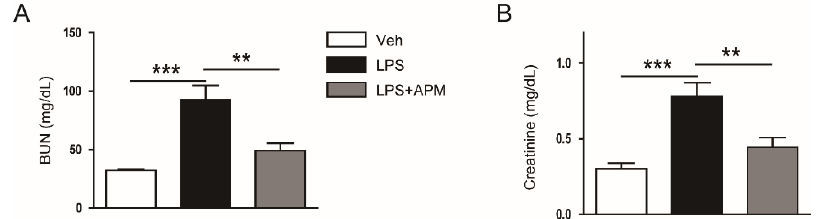
Figure 1. Effect of apamin on renal function in lipopolysaccharide (LPS)-treated mice. Apamin (APM; 0.1 mg/kg) was administered intraperitoneally to mice 1 h after LPS injection (10 mg/kg). ( A ) Blood urea nitrogen (BUN) levels. ( B ) Plasma creatinine levels. n = 8 per each group. ** p < 0.01 and *** p < 0.001.